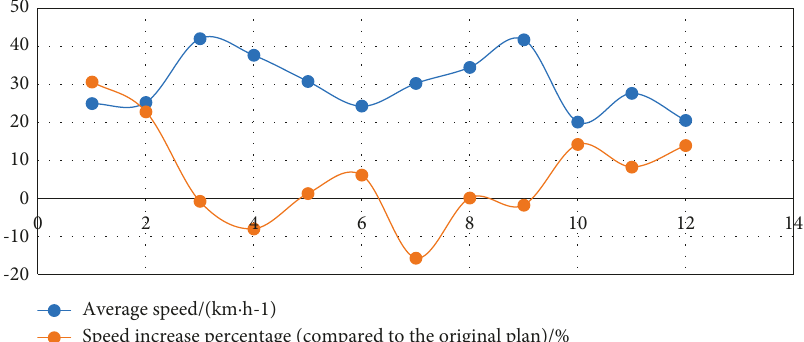
Figure 5: Traffic conditions at the intersection of the scenic spot during peak hours upon the change in the timing of the signal lights.